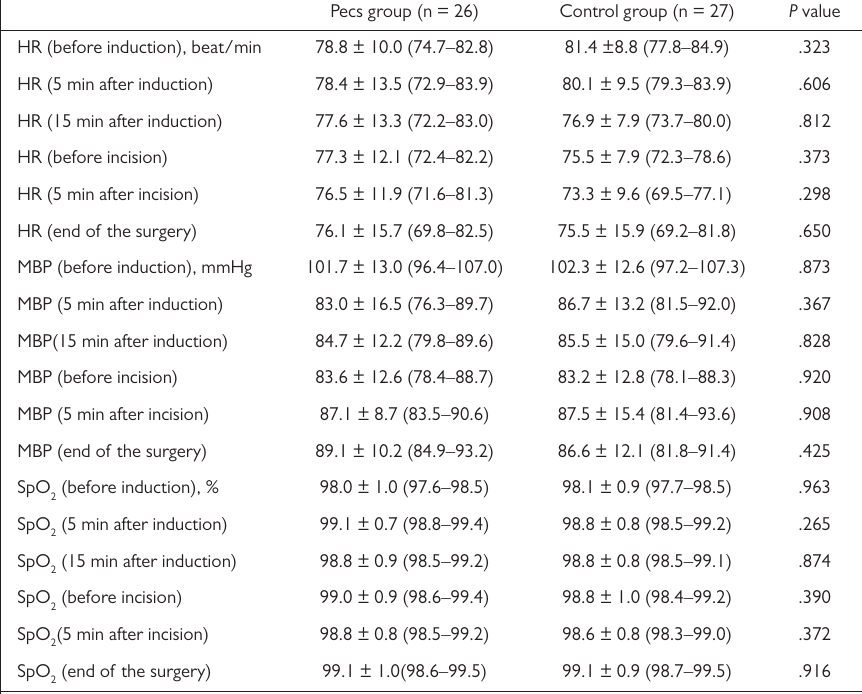
Table 2. Hemodynamic Findings of Patients